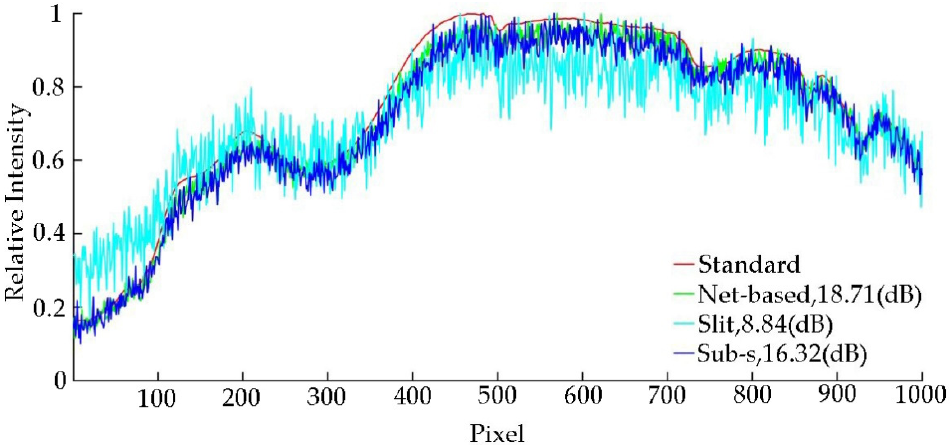
Figure 8. Comparison of different methods.